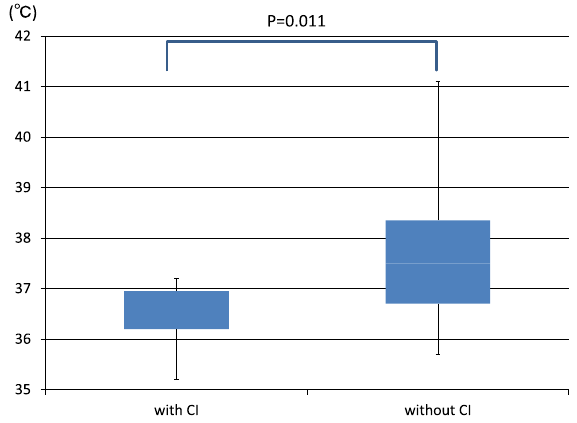
Figure 3 Comparison of the body temperature of the cerebral infarction group and the non-infarction group. The cerebral infarction group had lower body